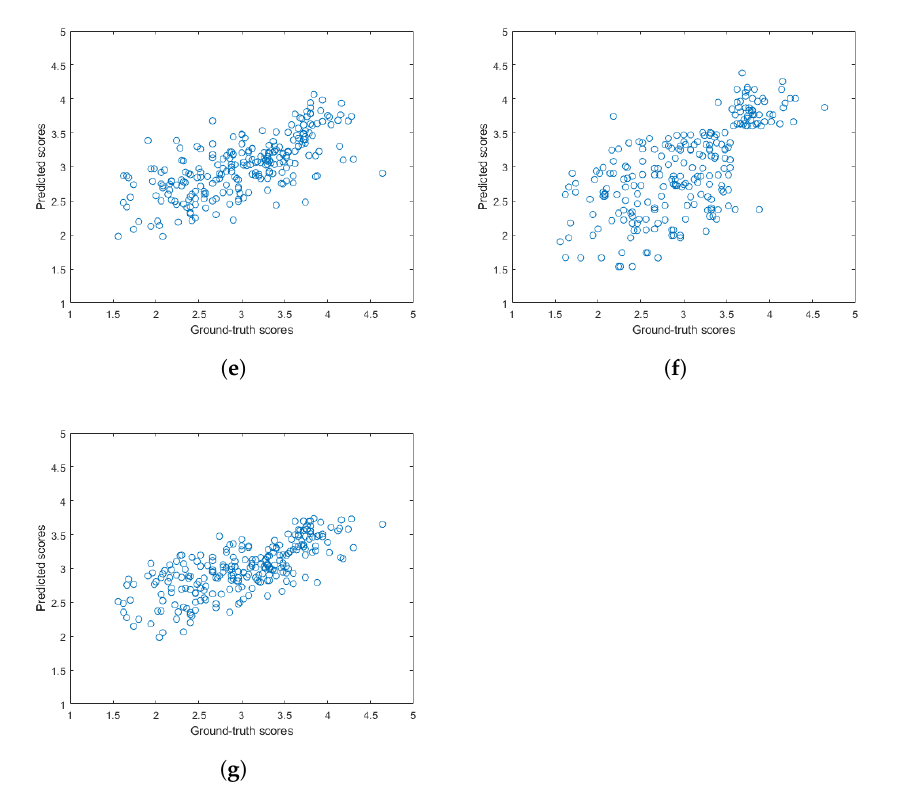
Figure 7. Scatterplots of the ground truth versus the predicted quality scores on a KoNViD-1k [16] test set for different regression techniques: ( a ) GAM, ( b ) LSBoost, ( c ) GPR, ( d ) NN, ( e ) RBF SVR, ( f ) BTR, and ( g ) ET.